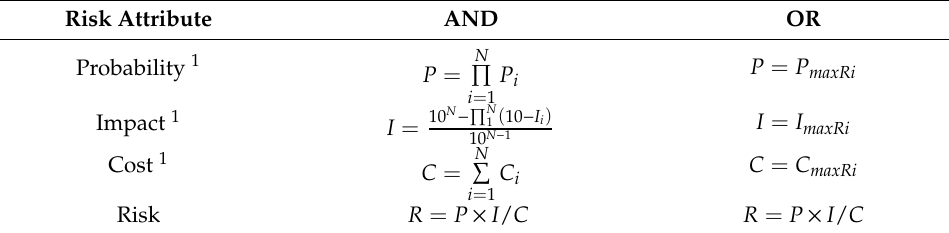
Table 2. Risk vector propagation rules in ADT for Equation